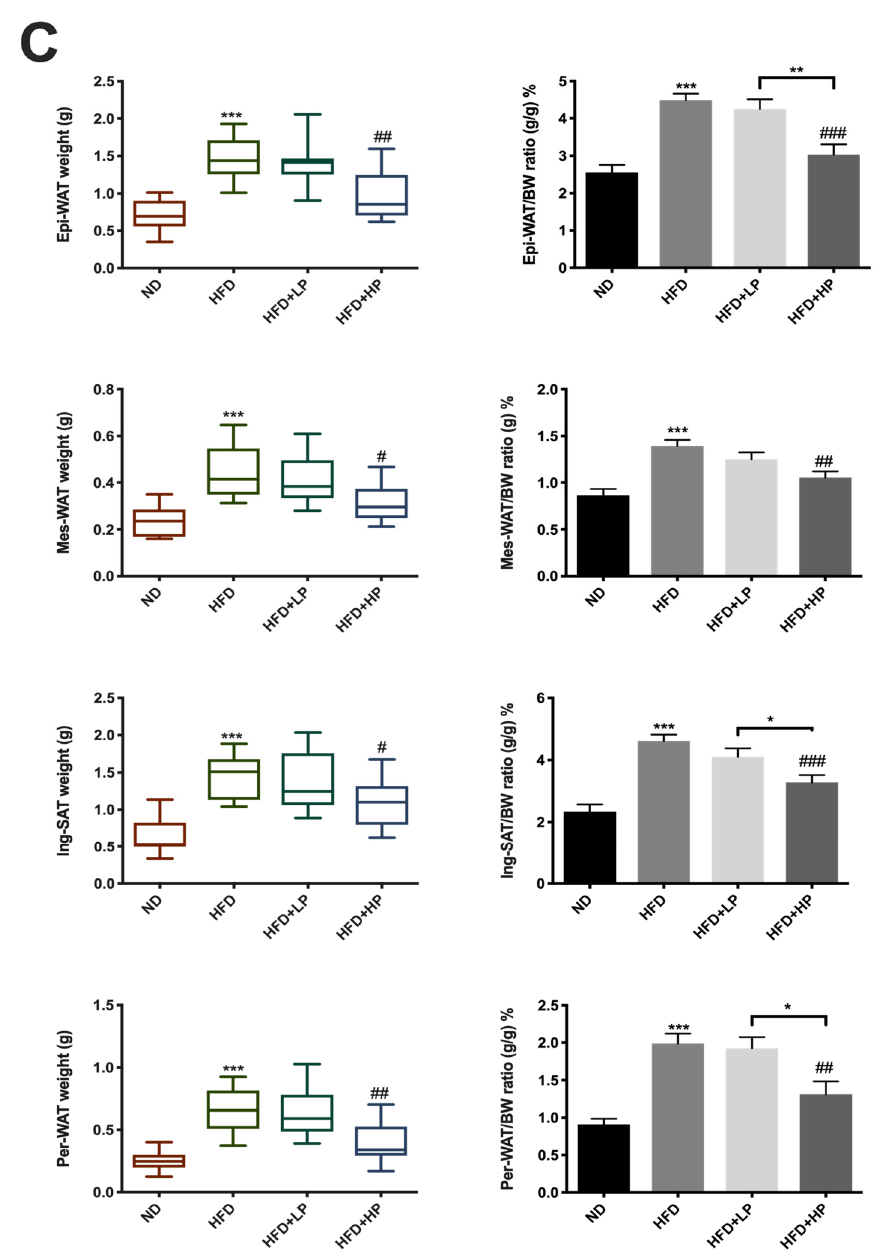
Figure 1. Chinese propolis (CP) prevented body weight gain and fat accumulation in both female and male high-fat diet (HFD)-fed mice. ( A ) The mean weight gain and weight of each group of both genders. ( B ) The weight of parametrial white adipose tissue (Par-WAT), mesenteric white adipose tissue (Mes-WAT), inguinal subcutaneous adipose tissue (Ing-SAT) and perirenal white adipose tissue (Per-WAT) and their ratios to body weight of female mice. ( C ) The weight of Par-WAT, Mes-WAT, Ing-SAT and Per-WAT as well as their ratios to body weight of male mice.